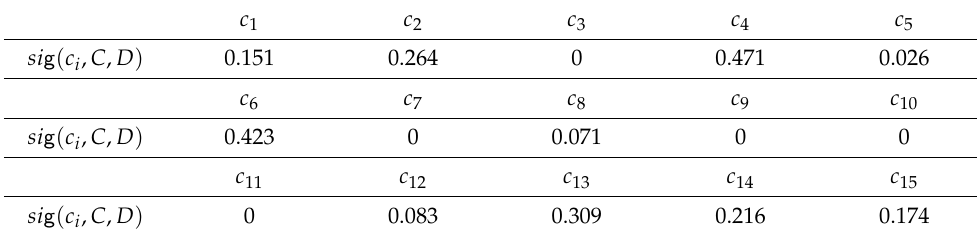
Table 3. The significance of each condition attribute of the left drum.